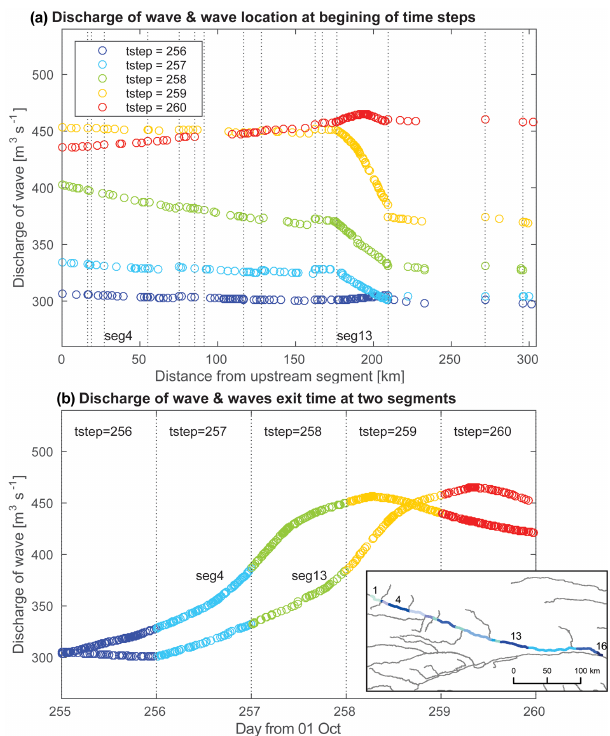
Figure 2. Visualization of waves. The top panel (a) plots a discharge of the wave [m 3 s − 1 ] against its location (distance [km] from the beginning of the 1st segment) at the beginning of five consecutive daily time steps. A vertical line indicates the river segment bound- ary. The bottom panel (b) plots a discharge of the wave [m 3 s − 1 ] against its exit time (day from 1 October) for the 4th and 13th seg- ments. A vertical line indicates the boundary of routing time step. The inserted map shows the 16 river segments used for the